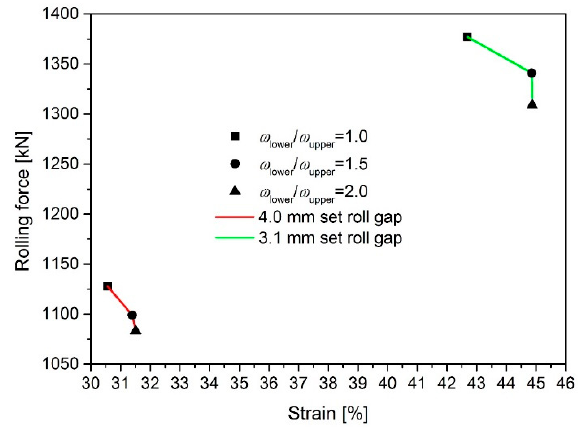
Figure 2. Measured rolling forces and calculated strains according to the two different roll